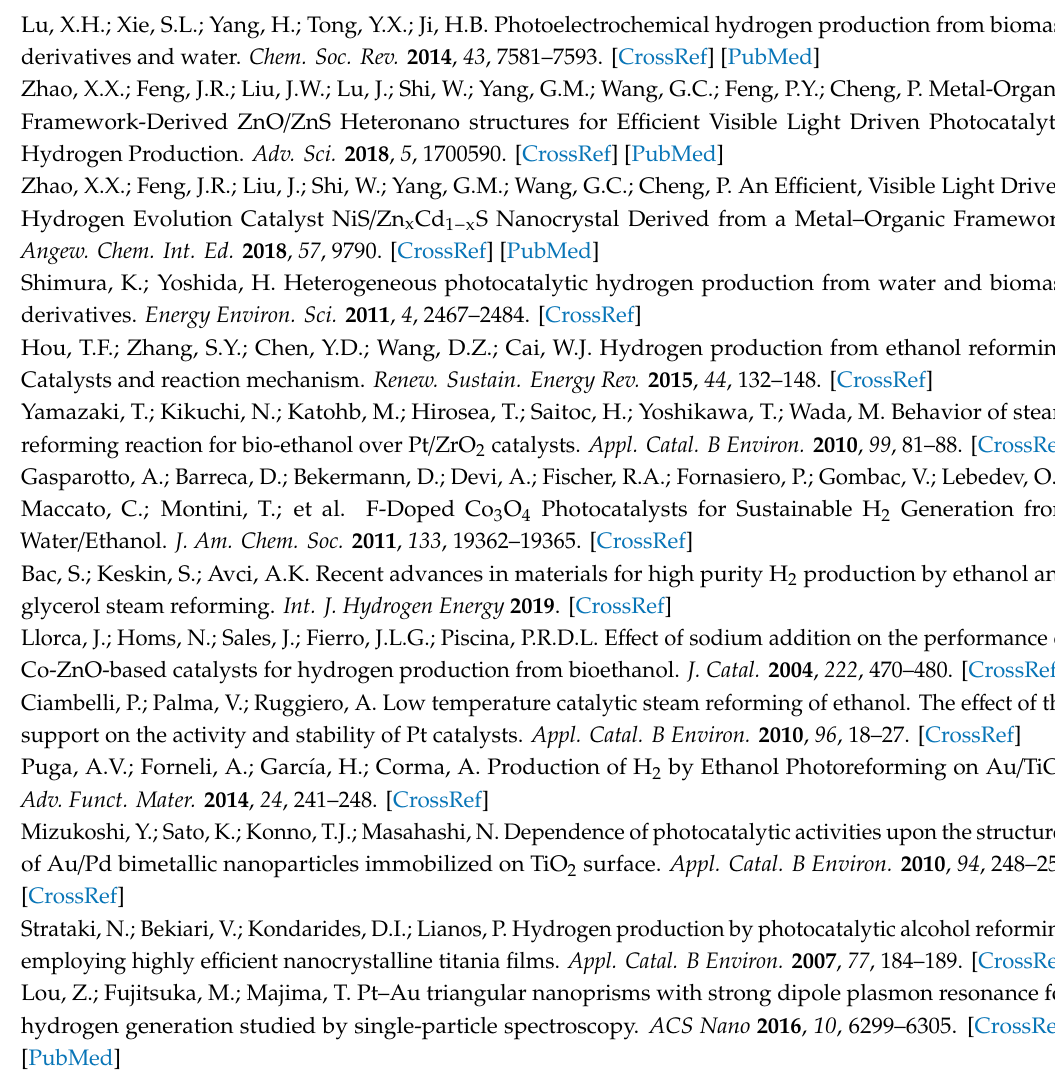
Figure S1: XRD patterns; Figure S2: GC-MS spectra; Figure S3: HRTEM photographs; Figure S4: Ti 2p, O 1s and Au 4f XPS spectra; Figure S5: Cu 2p XPS and Cu LMM Auger spectra; Figure S6: Bandgap estimation; Table S1: Ti 2p XPS analyses; Table S2: O 1s XPS analyses; Table S3: Au 4f XPS analyses; Table S4: Comparisons of photocatalysts for ethanol